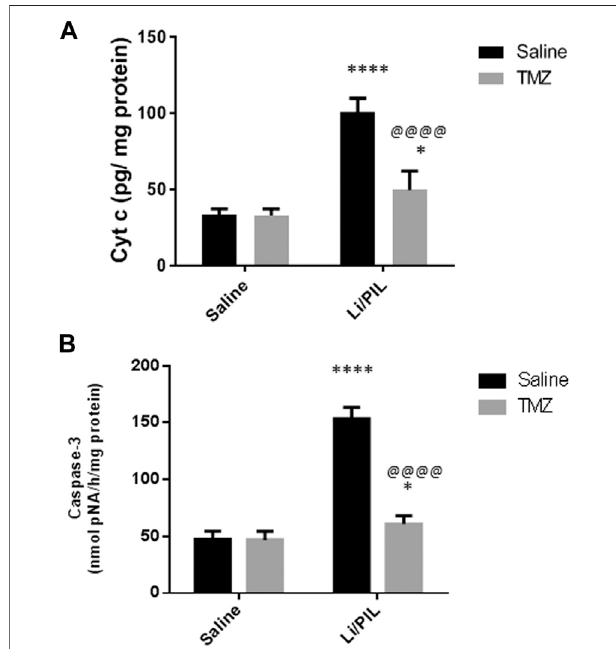
FIGURE 6 | Effect of TMZ on the Cyt c content and caspase-3 activity in rats with Li/PIL-induced seizures. (A) Cyt c content, (B) caspase-3 activity. Valuesareexpressedasmeanofsixanimals ± SD.Two-wayANOVAfollowed by the Tukey – Kramer post-hoc test was used for statistical analyses of data. *Signi fi cantly different from the normal control group (Saline) at p < 0.05; ****Signi fi cantly different from the normal control group (Saline) at p < 0.0001; @@@@ Signi fi cantly different from the Li/PIL control group at p <